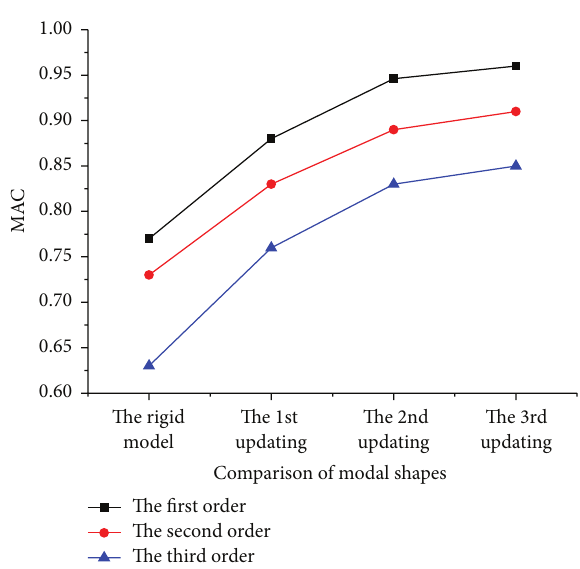
Figure 10: Comparison of modal